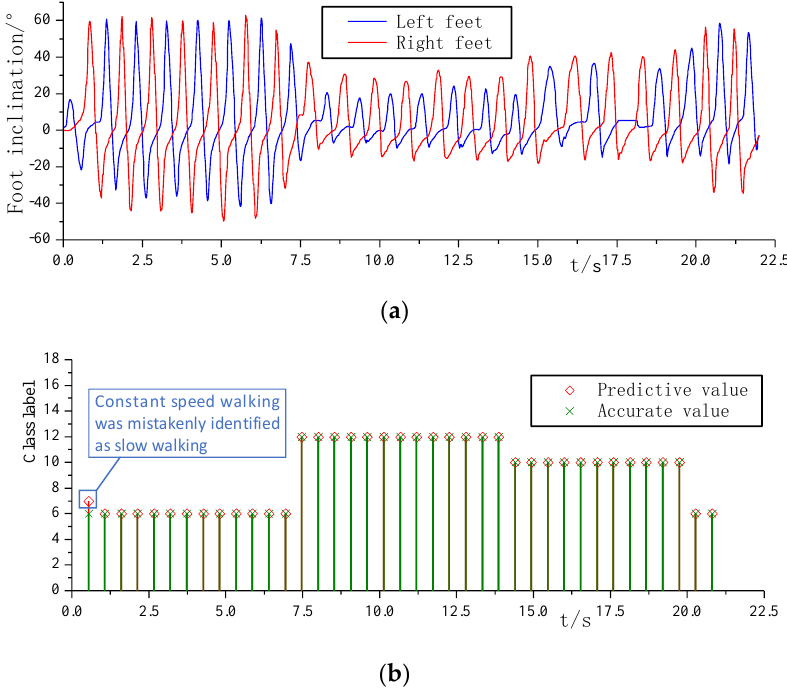
Figure 12. ( a ) Foot inclination during horizontal road and stair movement; ( b ) Identification results during horizontal road and stair